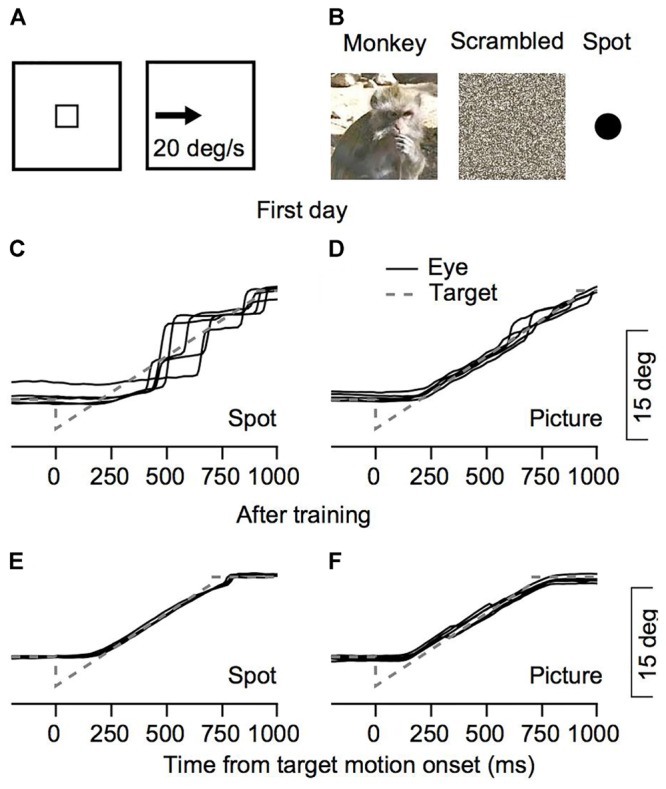
Behavioral task and examples of eye movements. (A,B) The snapshots illustrate the temporal structure of the task. The small square rectangle represents a target that was presented in the center of the screen which stepped to an eccentric position after a short delay and moved at constant speed. Three possible targets were interleaved in each session: a picture of a monkey, a scrambled version of this picture, or a spot. (C–F) Examples from Monkey C for eye position traces from the 1st day of training (C,D) and after extensive training (E,F). Solid black lines represent the eye position in the five trials in which Monkey C tracked a target that moved to the left. To insure these were not outliers we chose five trials where the rank of the fraction of pursuit displacement out of the total eye displacement was closest to the median. The gray dashed lines represent the target position.